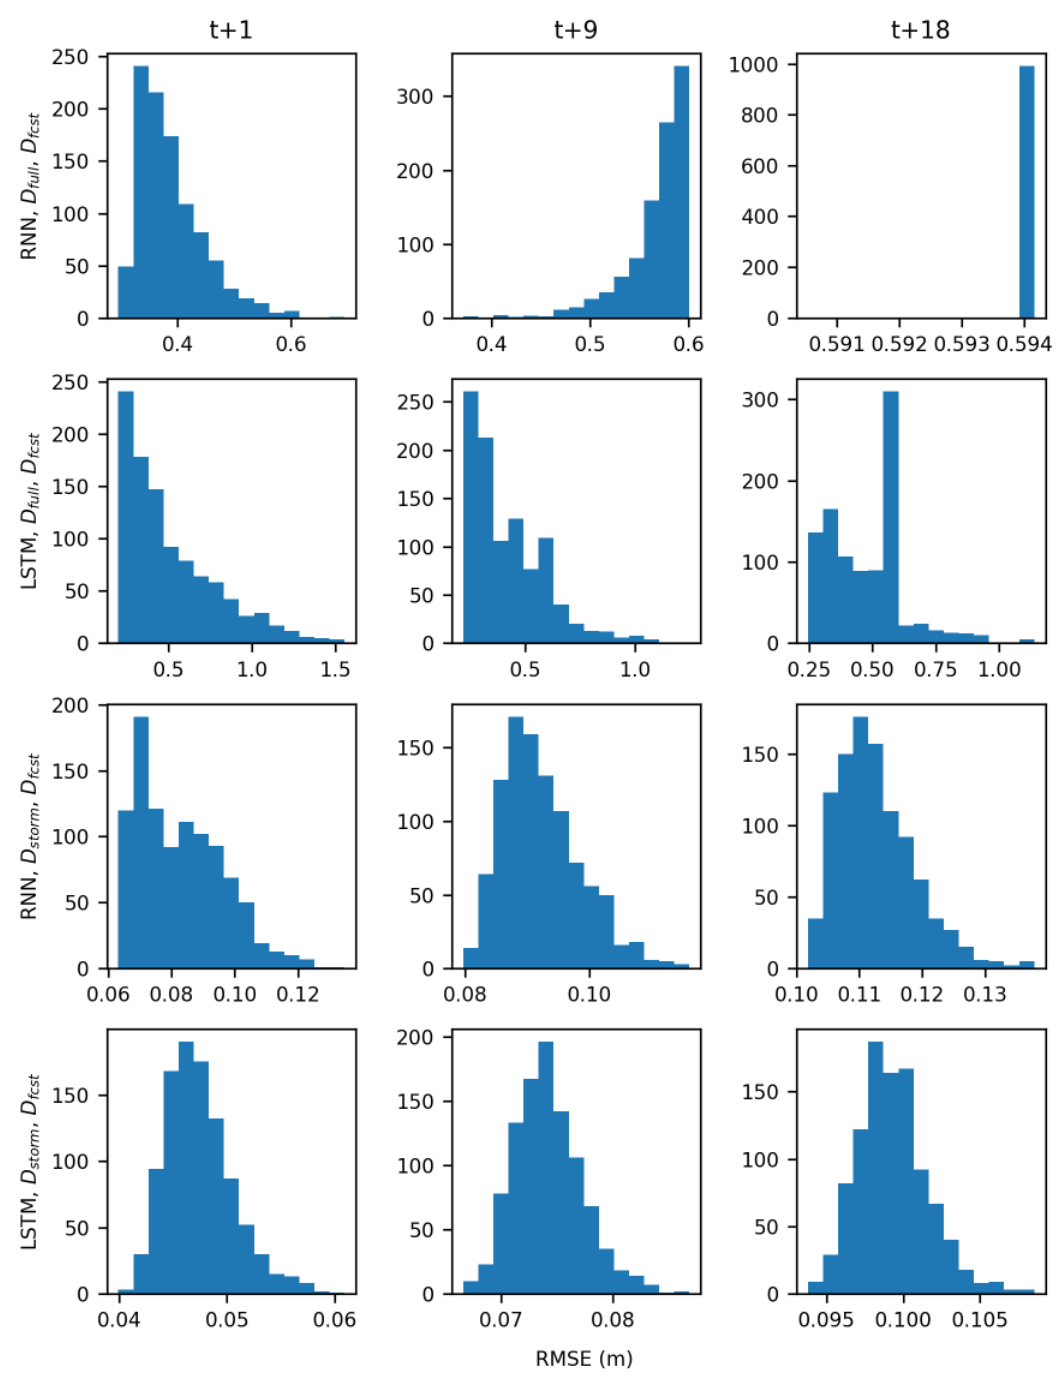
Figure A9. RMSE distributions for GW2 using forecast input data. Columns represent the forecast horizons t + 1, t + 9, and t + 18. Rows are specified as model type, training data, and testing data.